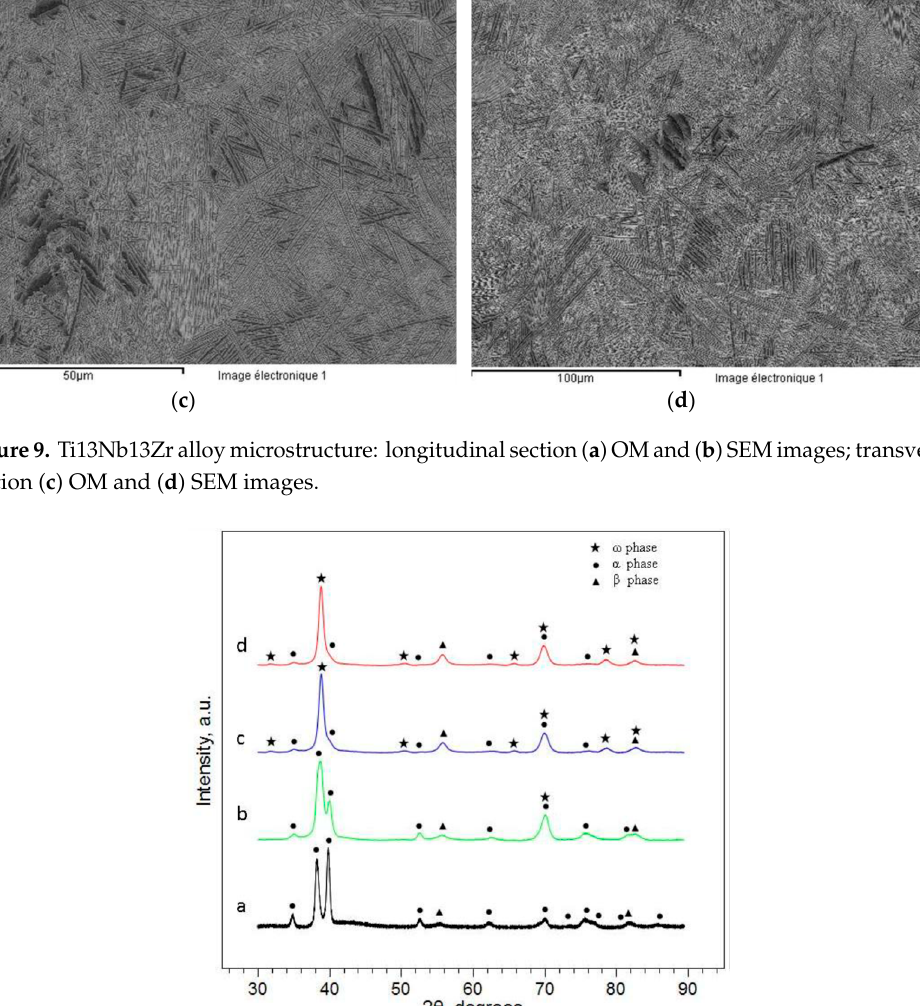
Figure 10. X-ray diffraction (XRD) patterns of the #2 ( a ) and #7( b ) 0 mm [ γ = 0], ( c ) 7mm [ γ = 220], and ( d ) 13 mm [ γ = 408] from the center of the sample. Shear strain due to high pressure torsion (HPT) deformation was calculated using the following equation: γ = 2 π rN/t, where r = distance from center to point of interest, N = number of rotations, and t = final thickness.